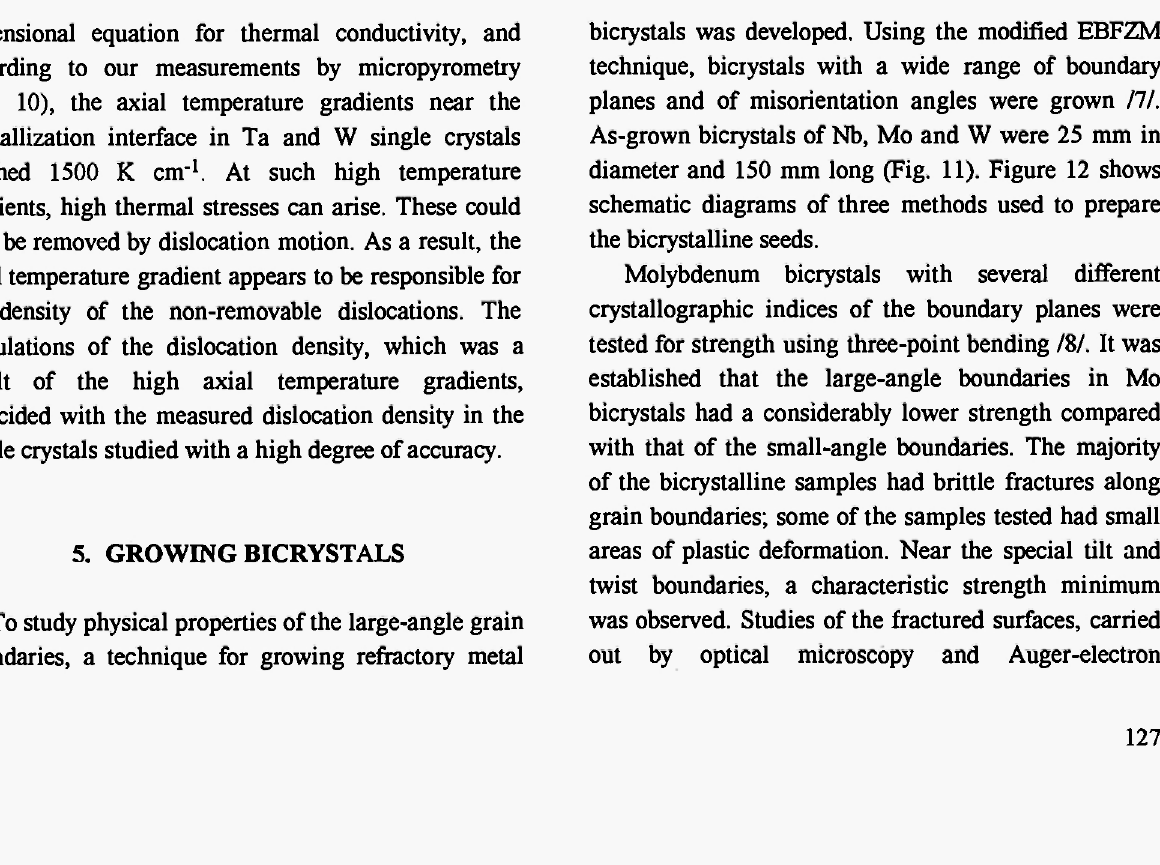
Fig. 10: Temperature distribution along the growth axis of Ta single